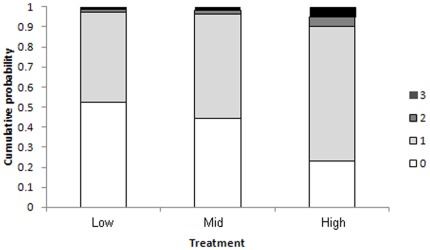
Fitted multinomial probabilities from the maximum likelihood of the proportional odds model from the ordinal logistic analysis.Where 0 = no response; 1 = eye movements towards the sound source; 2 = body movement towards the sound source; and 3 = move away from the sound source. The four shaded areas of the stacked bar chart represent the fitted probabilities of the four responses (0, 1, 2 & 3) for each treatment. 0 is represented in white, 1 in light grey and these represent minimal or no responses, 2 is represented by dark grey and 3 in Black and these represent the stronger responses of seals hearing the boat noise.